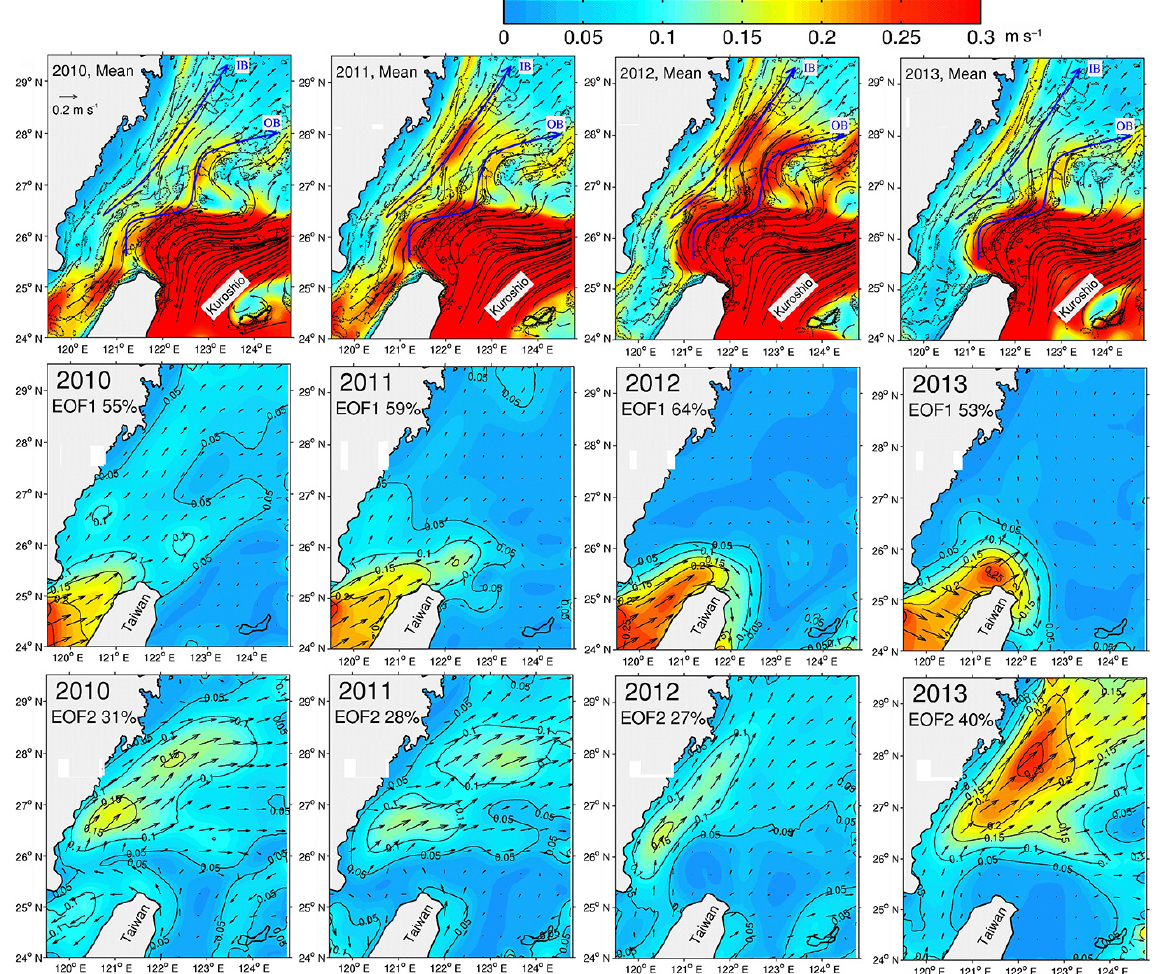
Figure 14. Mean currents (upper panels) and synoptic fluctuations (EOF1 in middle panels and EOF2 in bottom panels) in the winters of 2010–2013. The black arrows in the upper panels show the velocity (ms − 1 ) in the layer of VMV with the color representing the current speed. The two blue arrows with label IB and OB represent the flow axes of the inshore branch and offshore branch, respectively. The black arrows in the middle panels and bottom panels represent the EOF components (ms − 1 ) with their magnitude represented by color